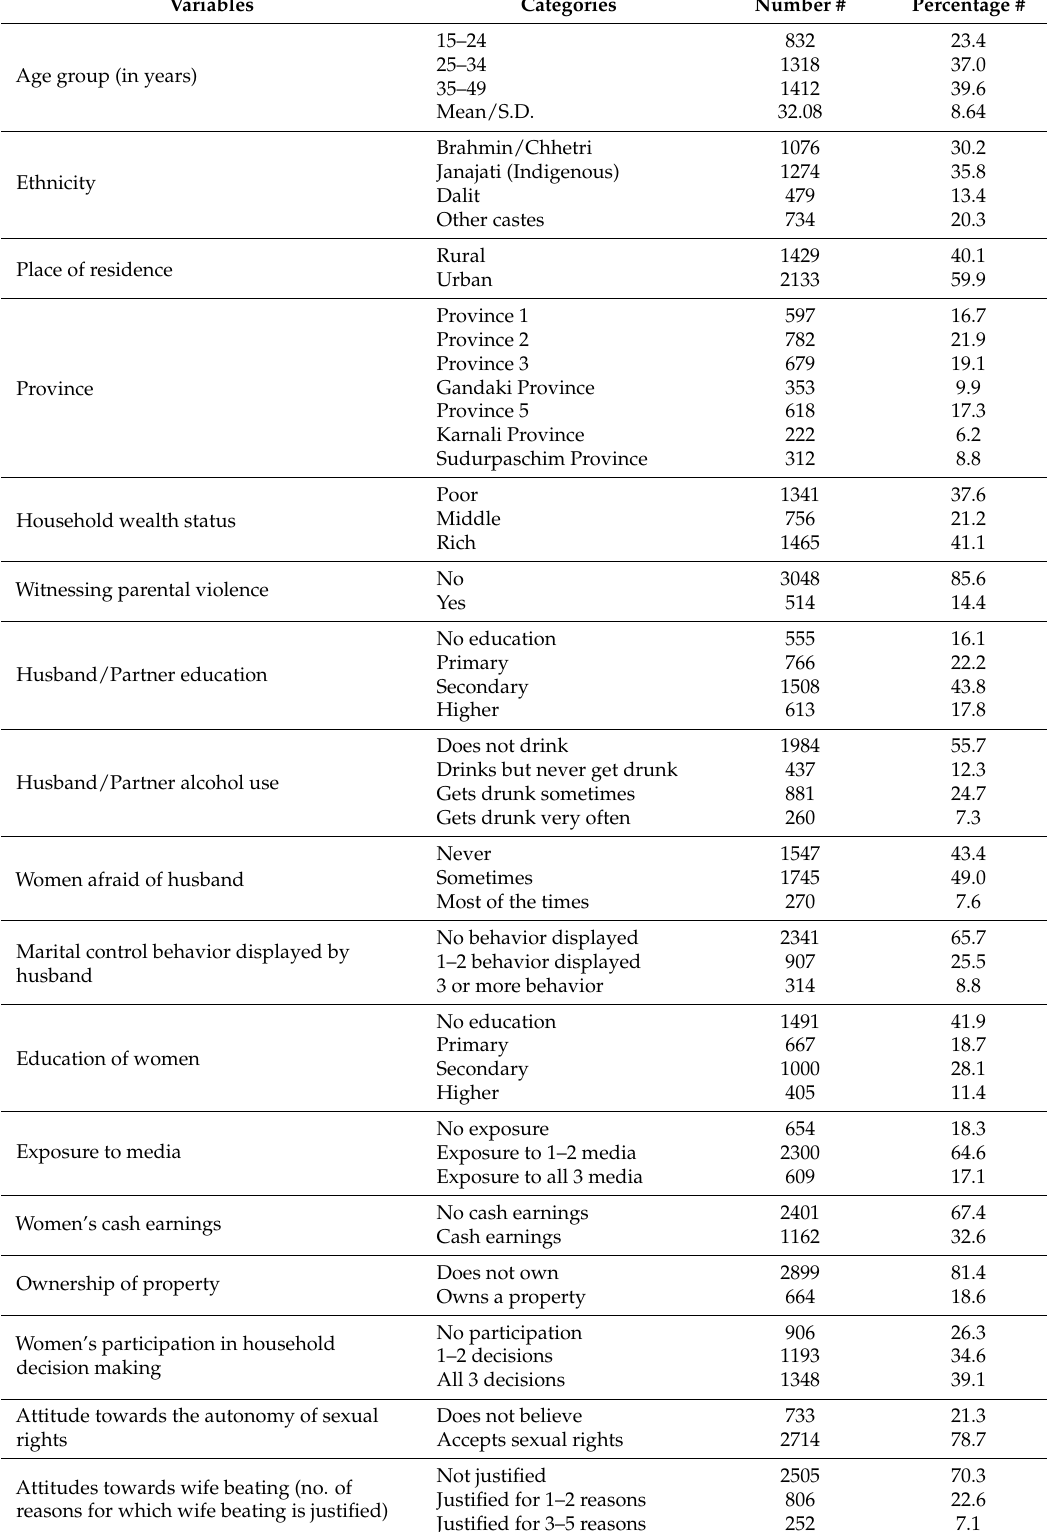
Table 3. Descriptive characteristics of the study population from the 2016 Nepal Demographic and Health Survey (NDHS) ( n =